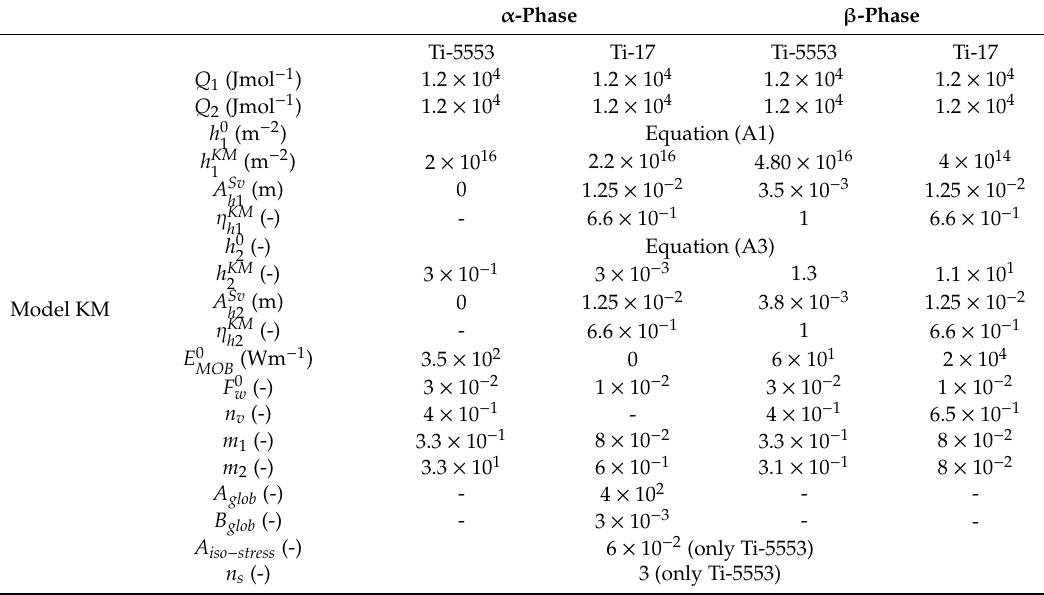
Table A4. Fitting parameters used in the developed